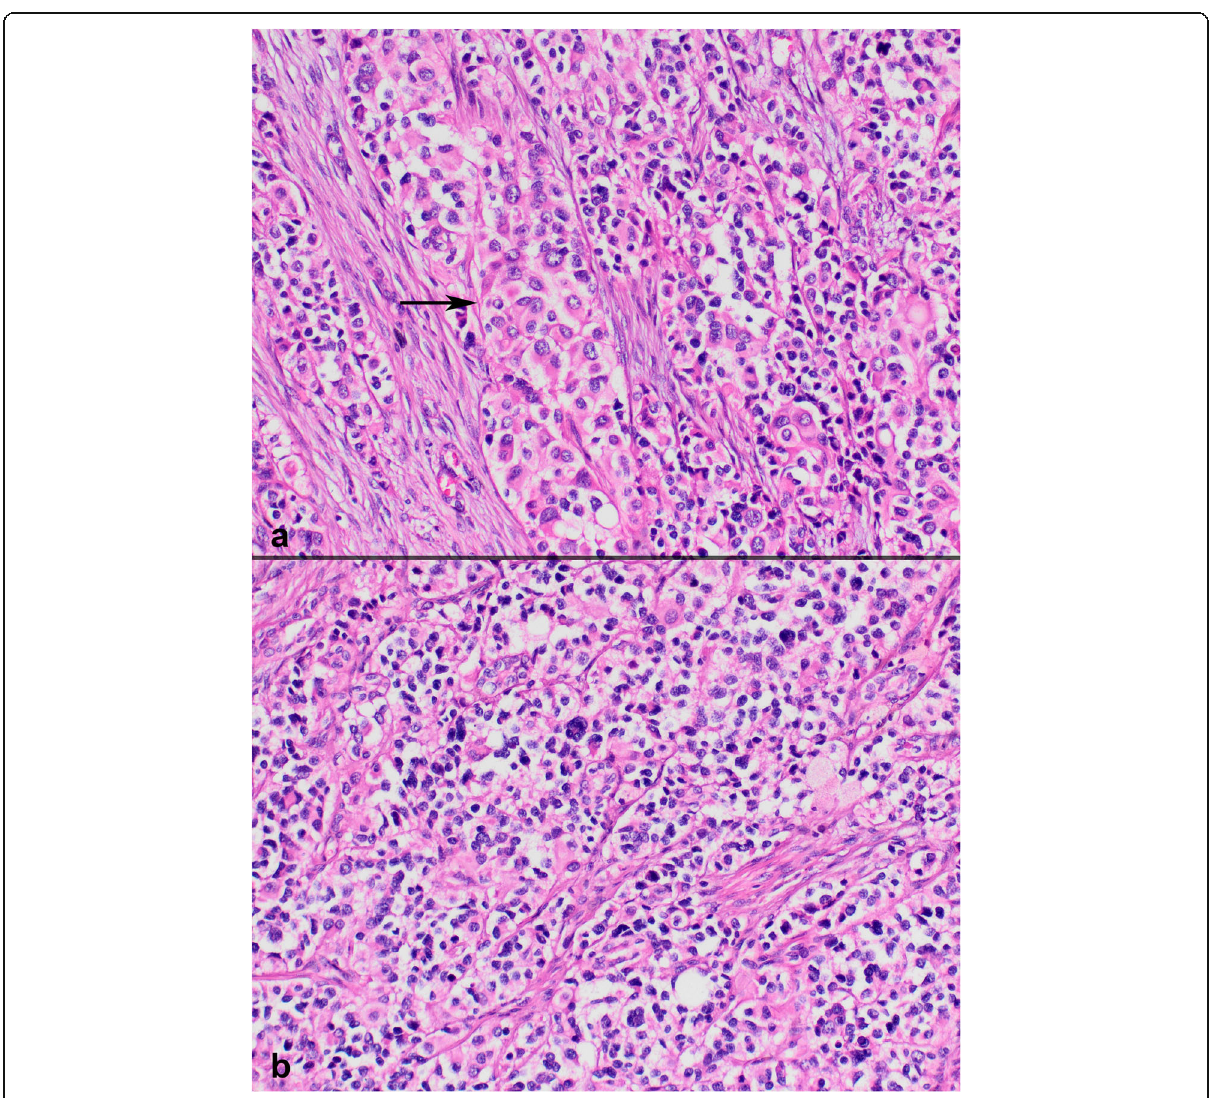
Fig. 4 Rhabdoid cells (pointed by an arrow) ( a ) and cells with clear cytoplasm or pleomorphic nuclei ( b ) ( a H&E × 200; b H&E ×